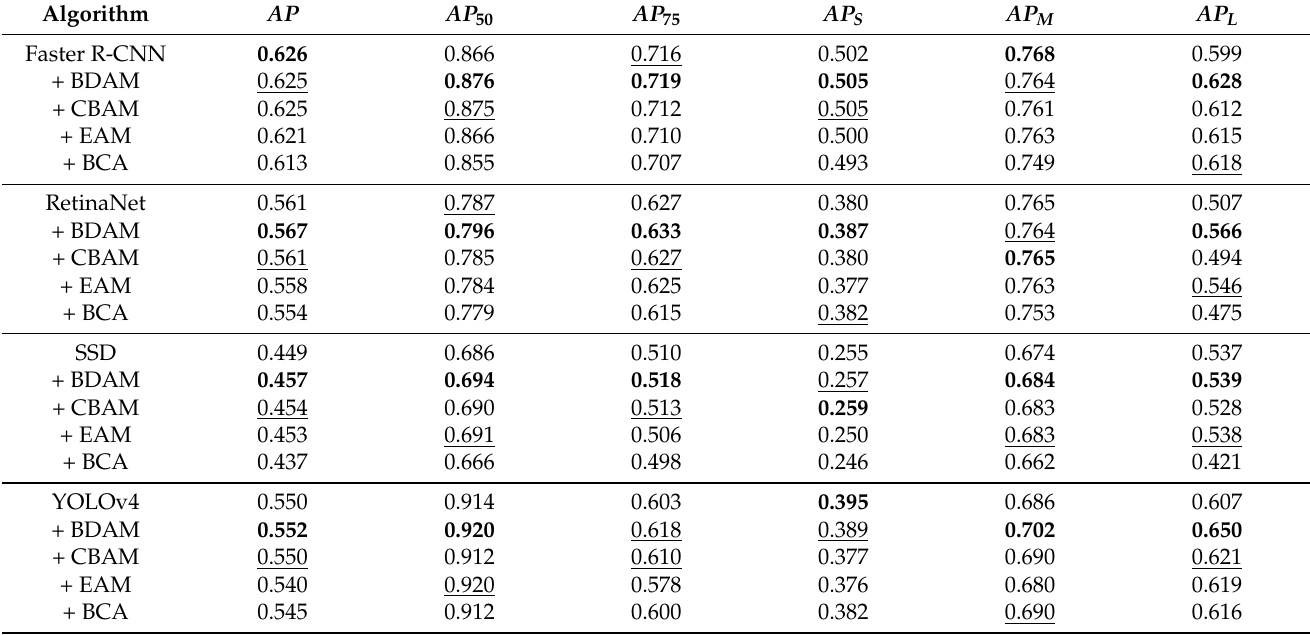
Table 7. Experimental results of different algorithms on dataset HRSID. Bolded data represent the best and underlined data represent the second